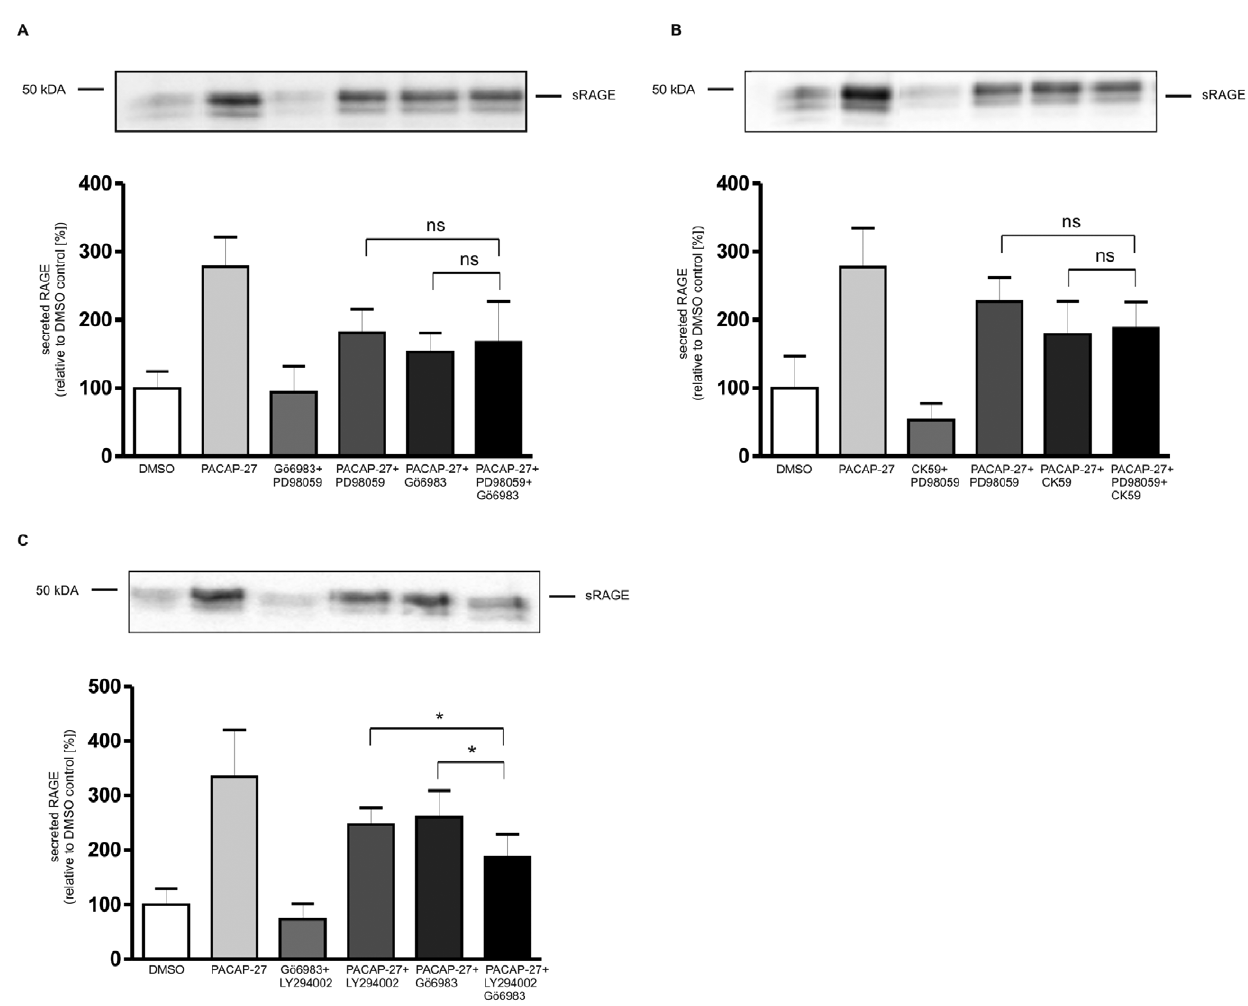
Figure 14. Influence of simultaneously added kinase inhibitors on the shedding of RAGE. PAC1/RAGE cells were pre-incubated for 1 h with (A) MEK1 inhibitor PD98059 (50 m M) and PKC inhibitor Go¨6983 (1 m M); (B) MEK1 inhibitor PD98059 (50 m M) and CaMKII inhibitor CK59 (20 m M) or (C) PI3K inhibitor LY294002 (50 m M) and PKC inhibitor Go¨6983 (1 m M). Then 300 nM PACAP-27 was added for 2 h. Secreted RAGE was detected and quantified as described in Figure 1. Shown are the mean effects 6 S.D., significance was determined by the One-way ANOVA test (ns=P . 0.05; * = P , 0.05).